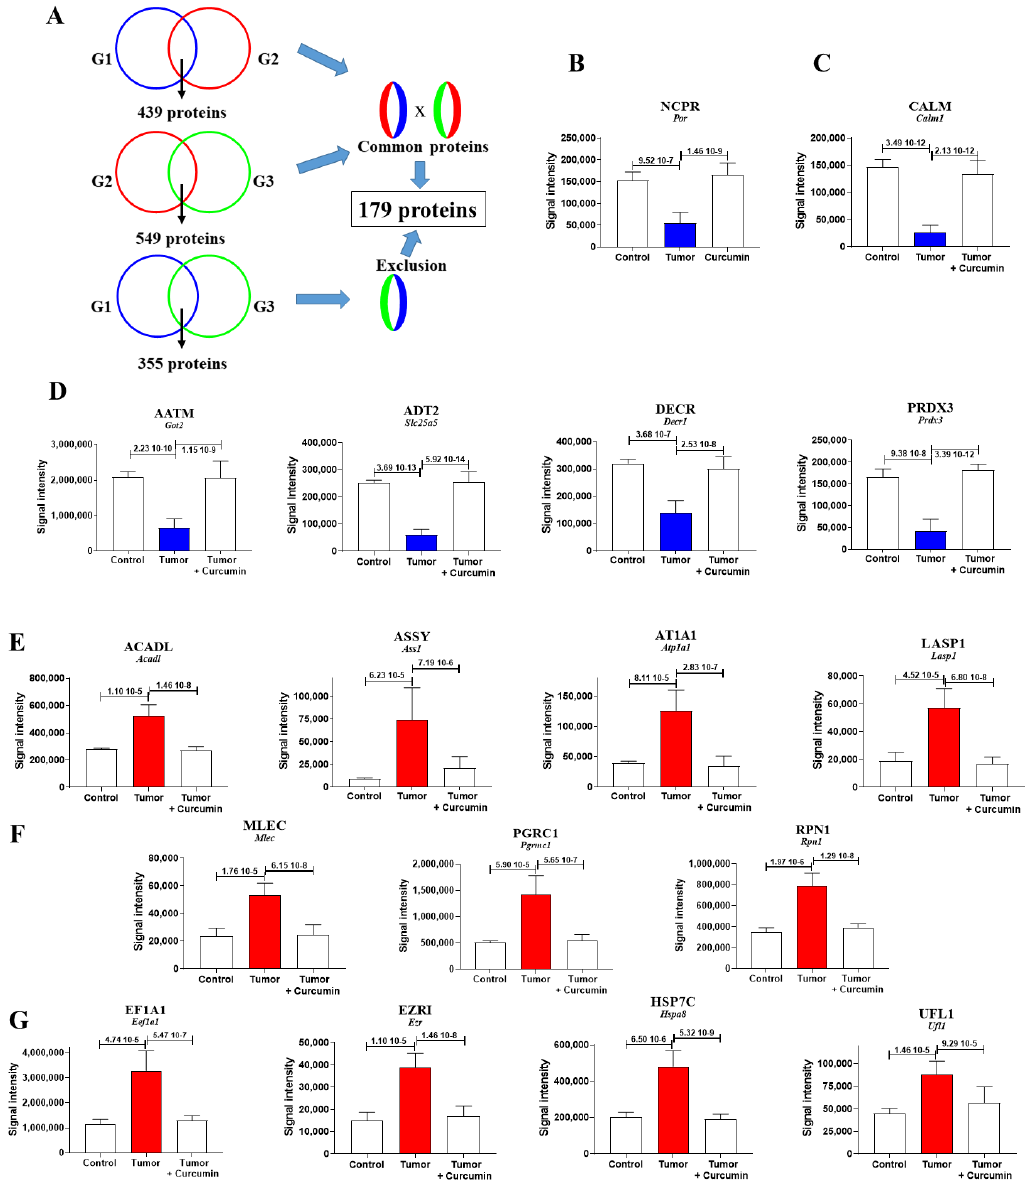
Figure 3. Liver biomarkers exhibiting the most dramatic quantitative changes under metastatic colonization by M5-T1 cells. ( A ) Diagram of the method used to identify the 179 biomarkers of